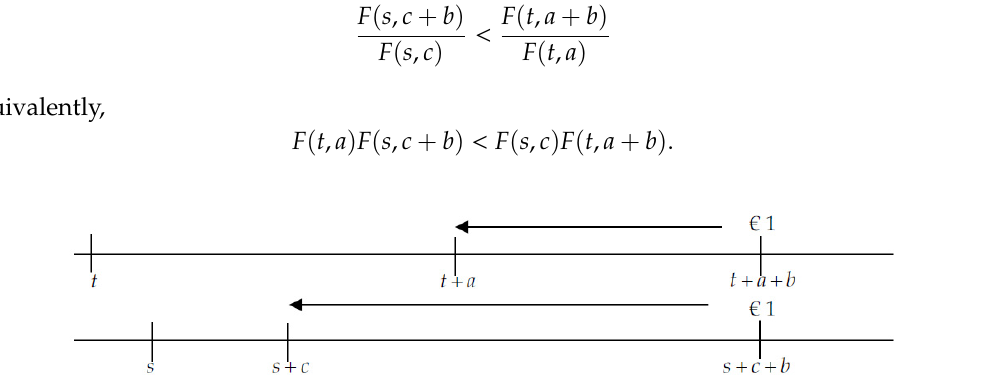
Figure 4. Delay e ff ect in a dynamic situation. Source: Own elaboration. Figure 4. Delay effect in a dynamic situation. Source: Own elaboration.